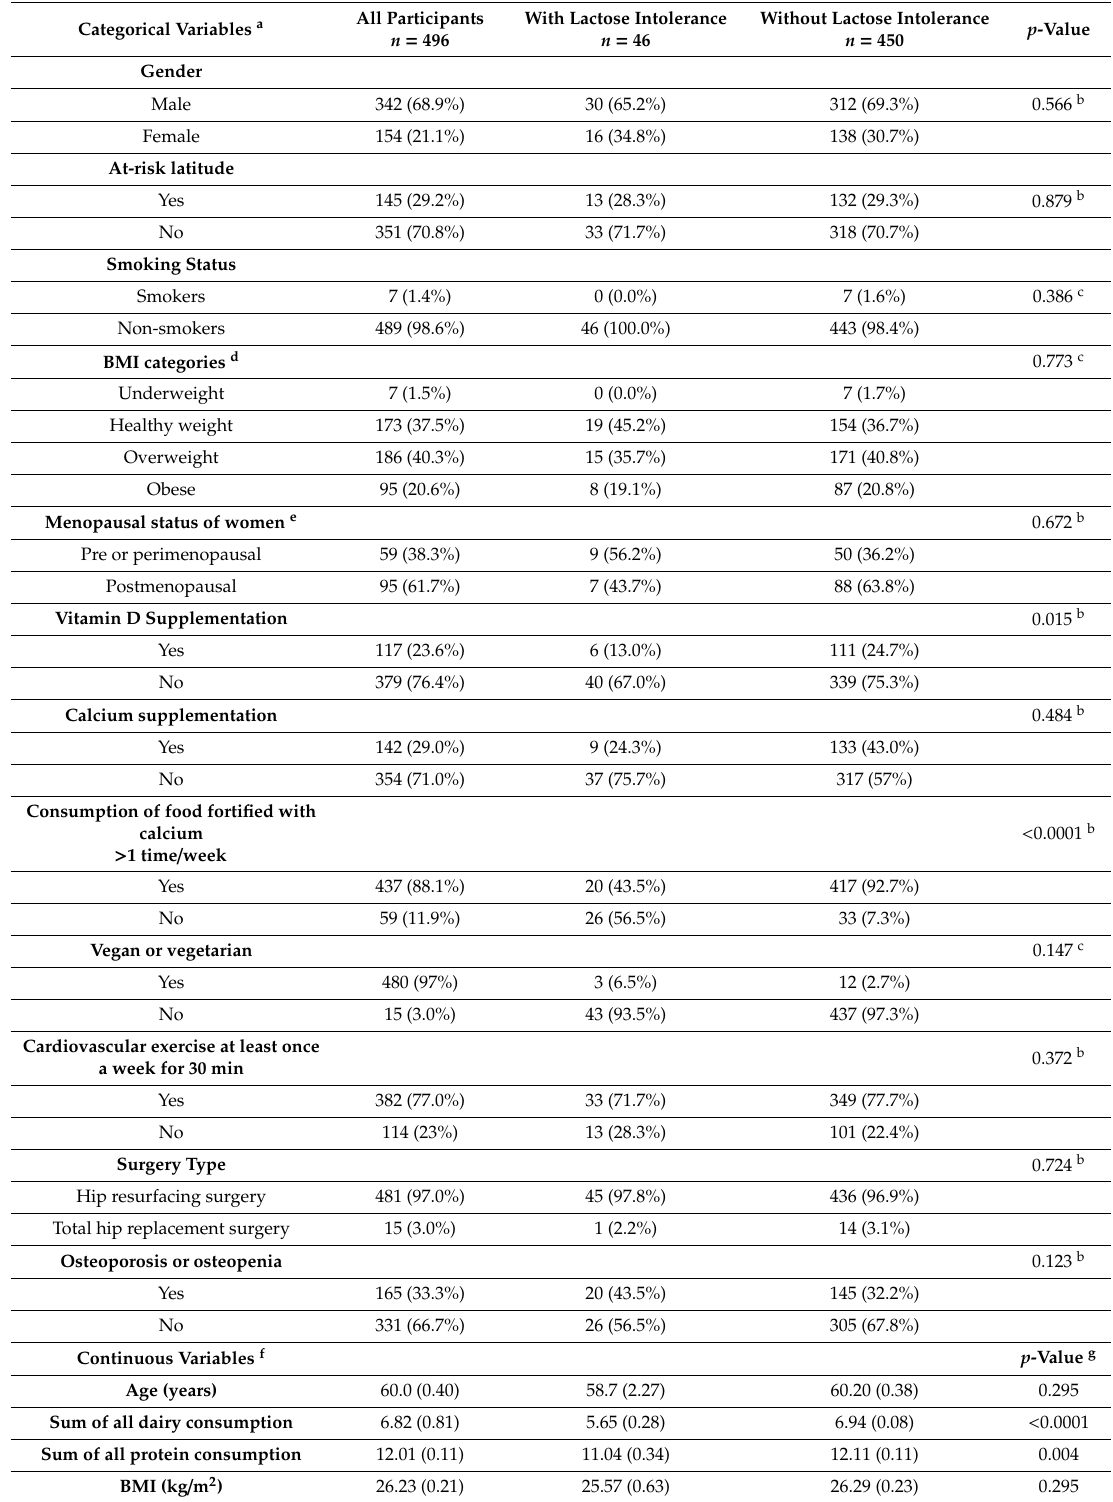
Table 1. Characteristics of patients who received hip arthroplasty between 2003 and 2017; Columbia, South Carolina, United States of